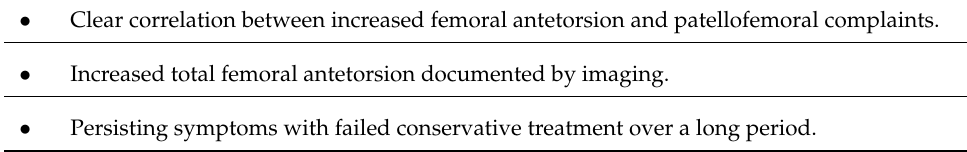
Table 1. Indications for femoral external rotation